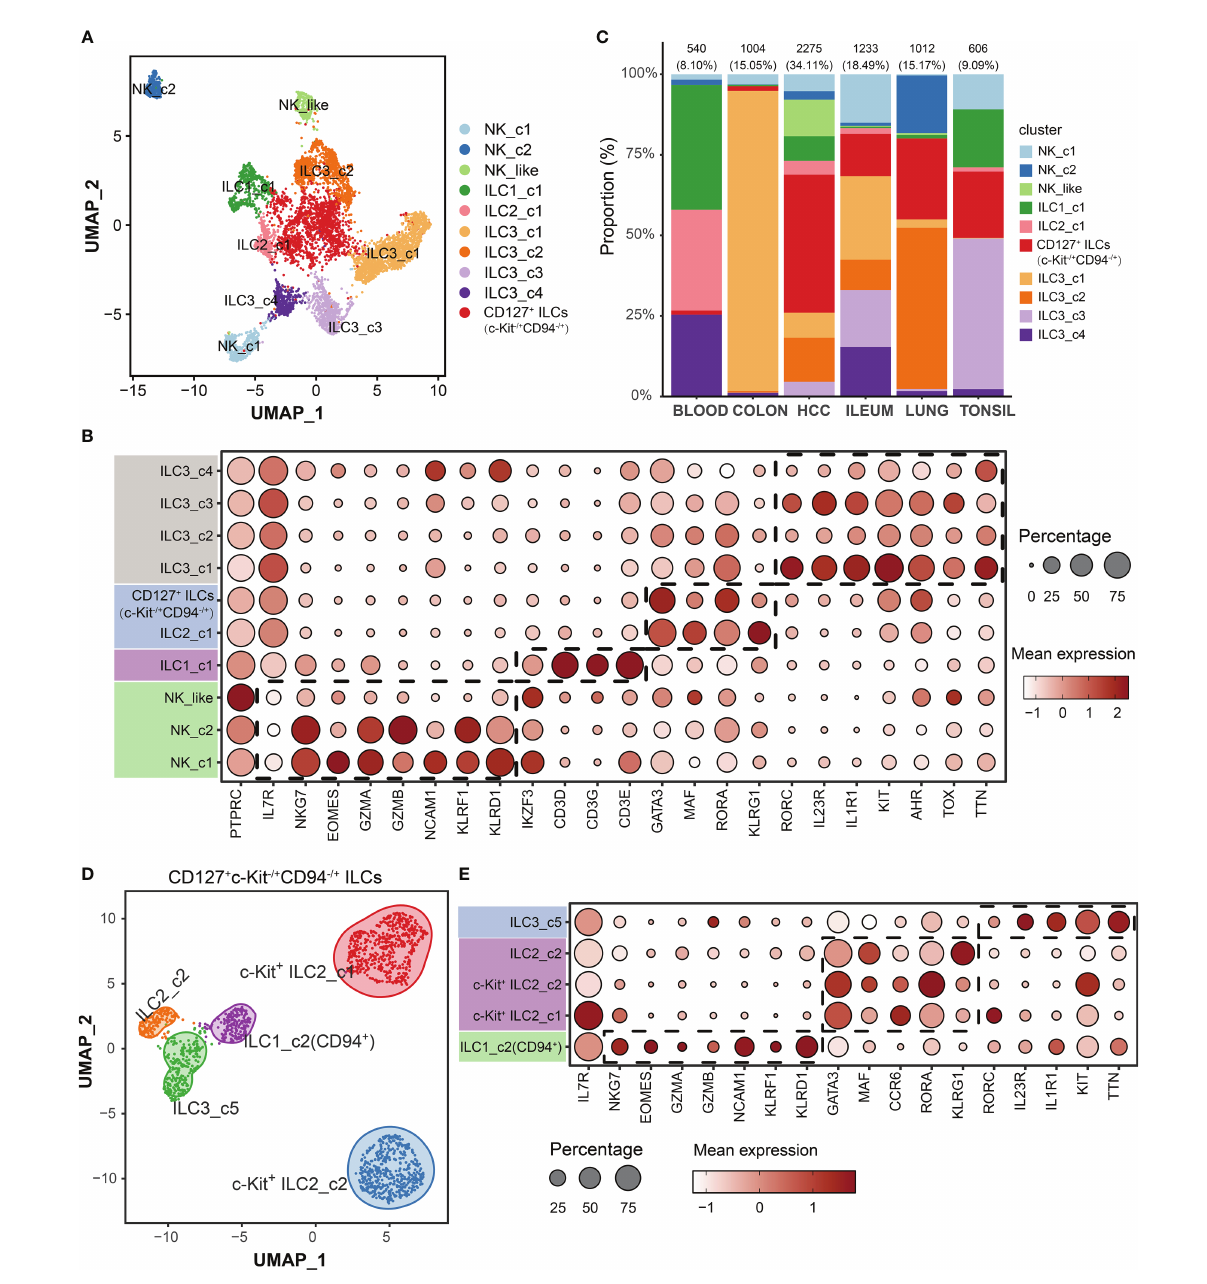
FIGURE 2 Single-cell transcriptome pro fi les of ILCs among different tissues. (A) UMAP visualization of all cells (6670) color-coded on the basis of annotated clusters. (B) Dot plot displaying average and percent expression of marker genes across ten ILC clusters. (C) Proportion of each cell type among different tissues. (D) UMAP visualization of c-Kit -/+ ILC2/ILC3 subset (1537 cells). (E) Dot plot displaying average and percent expression of marker genes for c-Kit -/+ ILC2/ILC3 subset across fi ve